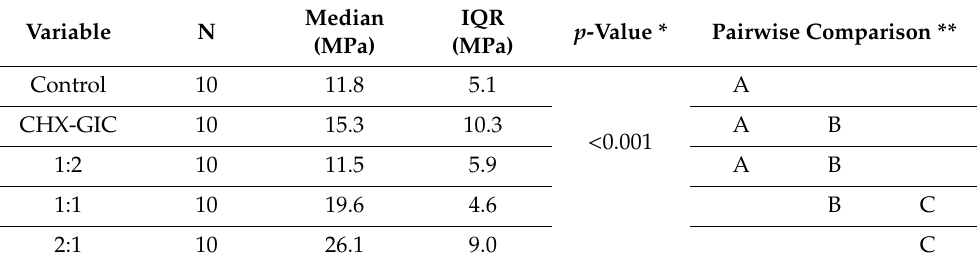
Table 3. Results of Kruskal–Wallis H test and pairwise comparison for the flexural strength values of the control, CHX, and three plant-modified groups (1:2, 1:1, 2:1). Median IQR p -Value * Pairwise Comparison ** Variable N (MPa) (MPa) Control 10 11.8 5.1 A CHX-GIC 10 15.3 10.3 A B < 0.001 1:2 10 11.5 5.9 A B 1:1 10 19.6 4.6 B C 2:1 10